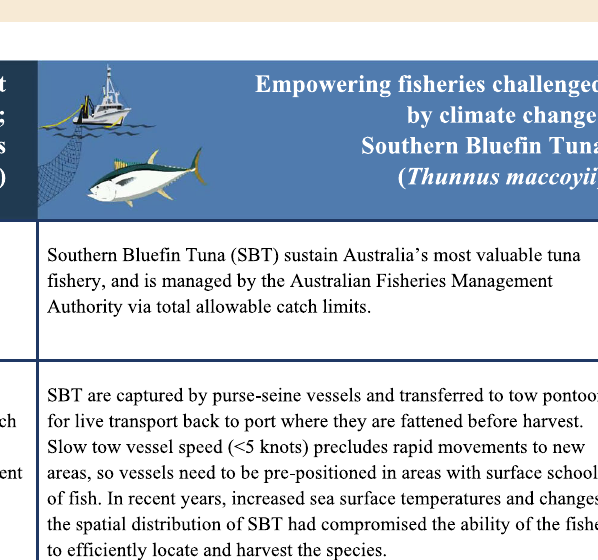
Table 1 Detailed overview of two science – policy – practice bright spots, including the science need, research outcomes and impacts